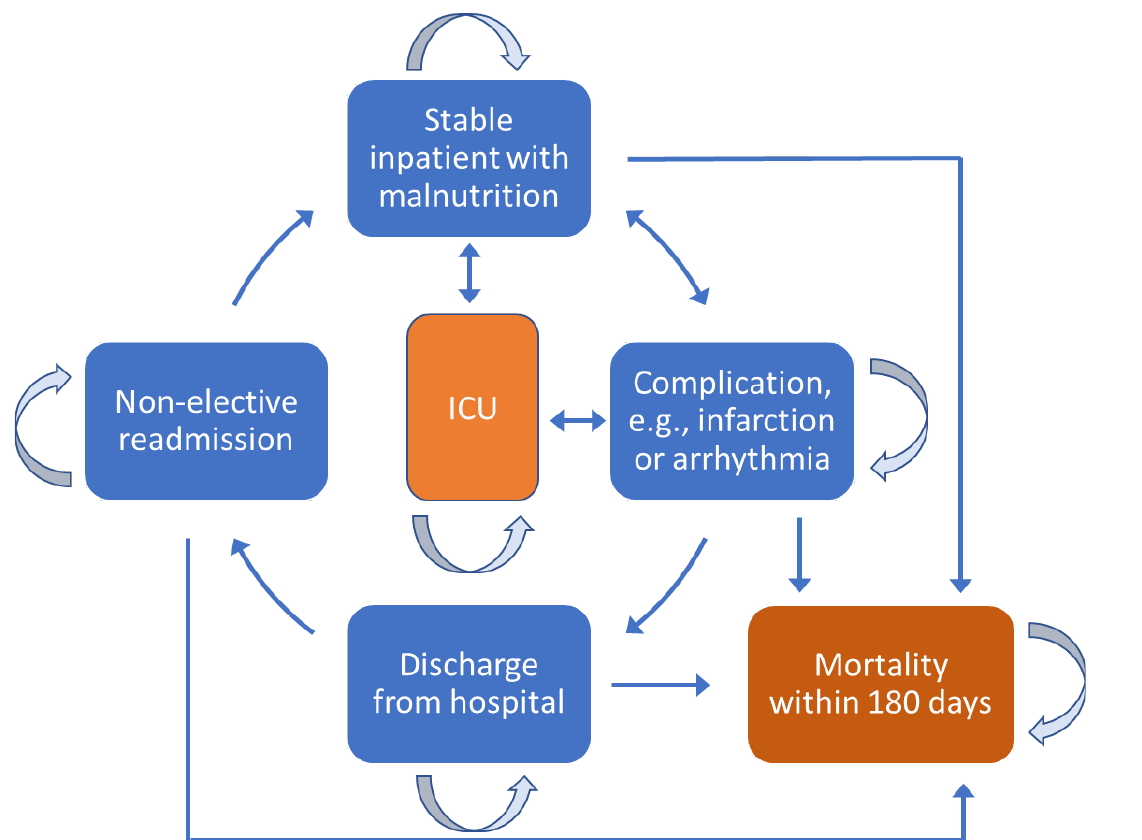
Figure 1. Health states of the Markov model. Light blue arrows represent patients staying within the given health state, while bright blue arrows represent transitions between states. Abbreviation: ICU, intensive care unit.